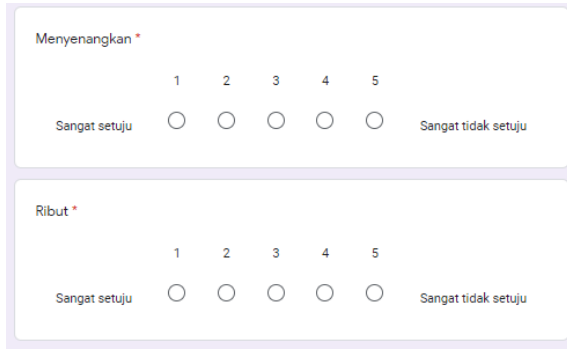
Fig. 3. Online questionnaire used in the experiment.